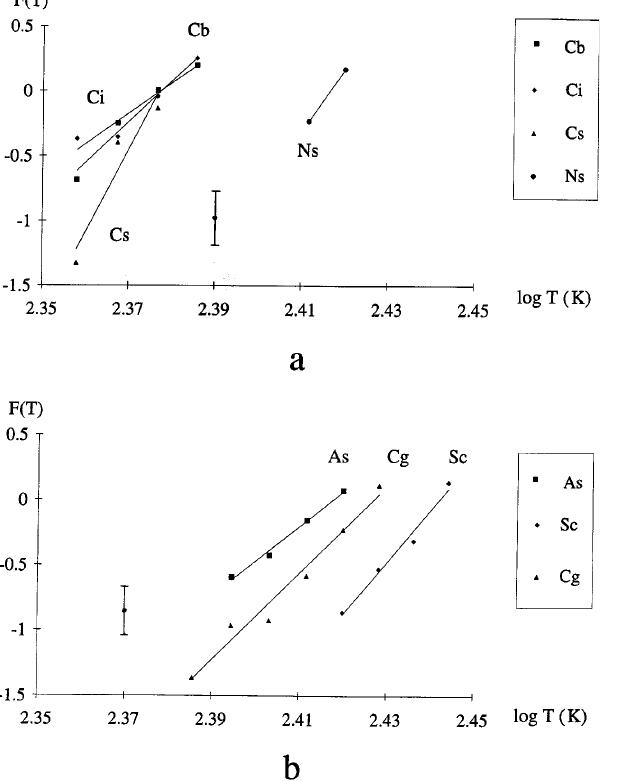
Fig. 8a, b. Cumulative frequency distributions of top temperature ( T , in K) and Weibull fitting with m (cid:136) 0: a for types Cb, Ci, Cs, Ns; b for types As, Sc, Cg. The error bar displayed is calculated using Eq. (16) and an accuracy of 2 K on temperatures